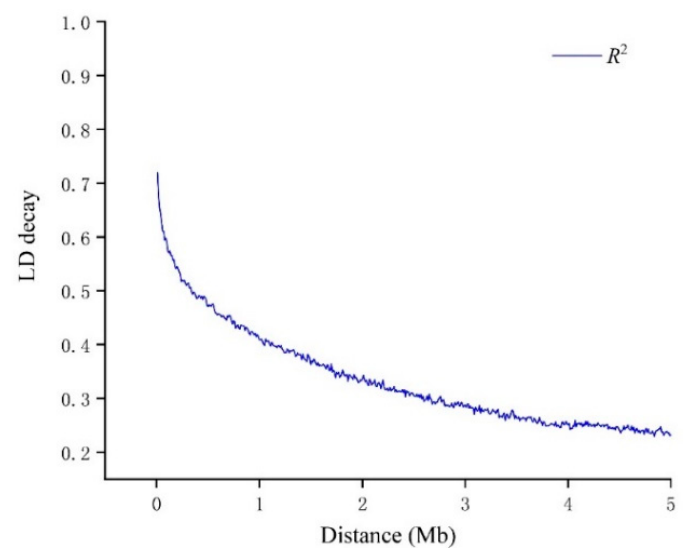
Figure 4. Genome-wide average linkage disequilibrium (LD) decay in the population of 347 soybean lines. The mean LD decay rates were estimated by the squared correlation coefficient ( R 2 ).